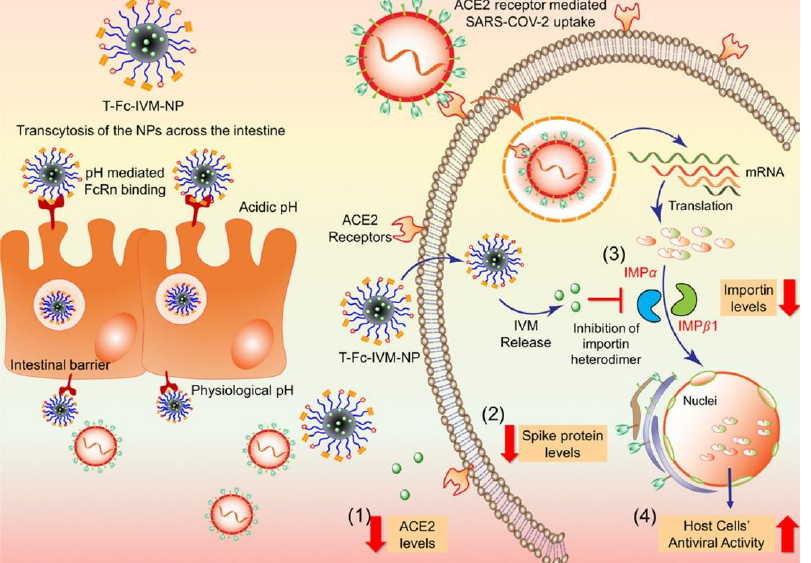
Figure 4. Graphical representation of the targeted-Fc-IVM-NPs in the acidic gut lumen binding FcRn receptors and allowing NPs to transcytose across the intestinal barrier. IVM delivered via T-Fc-IVM-NPs shows the ability to (1) decrease ACE2 receptor levels, (2) decrease SARS-CoV-2 spike protein levels, and (3) decrease levels of the nuclear transport proteins importin α and β1, which leads to (4) an increase in the antiviral activity of infected cells. (Reproduced with permission from [110]. Copyright American Chemical Society, 2020).